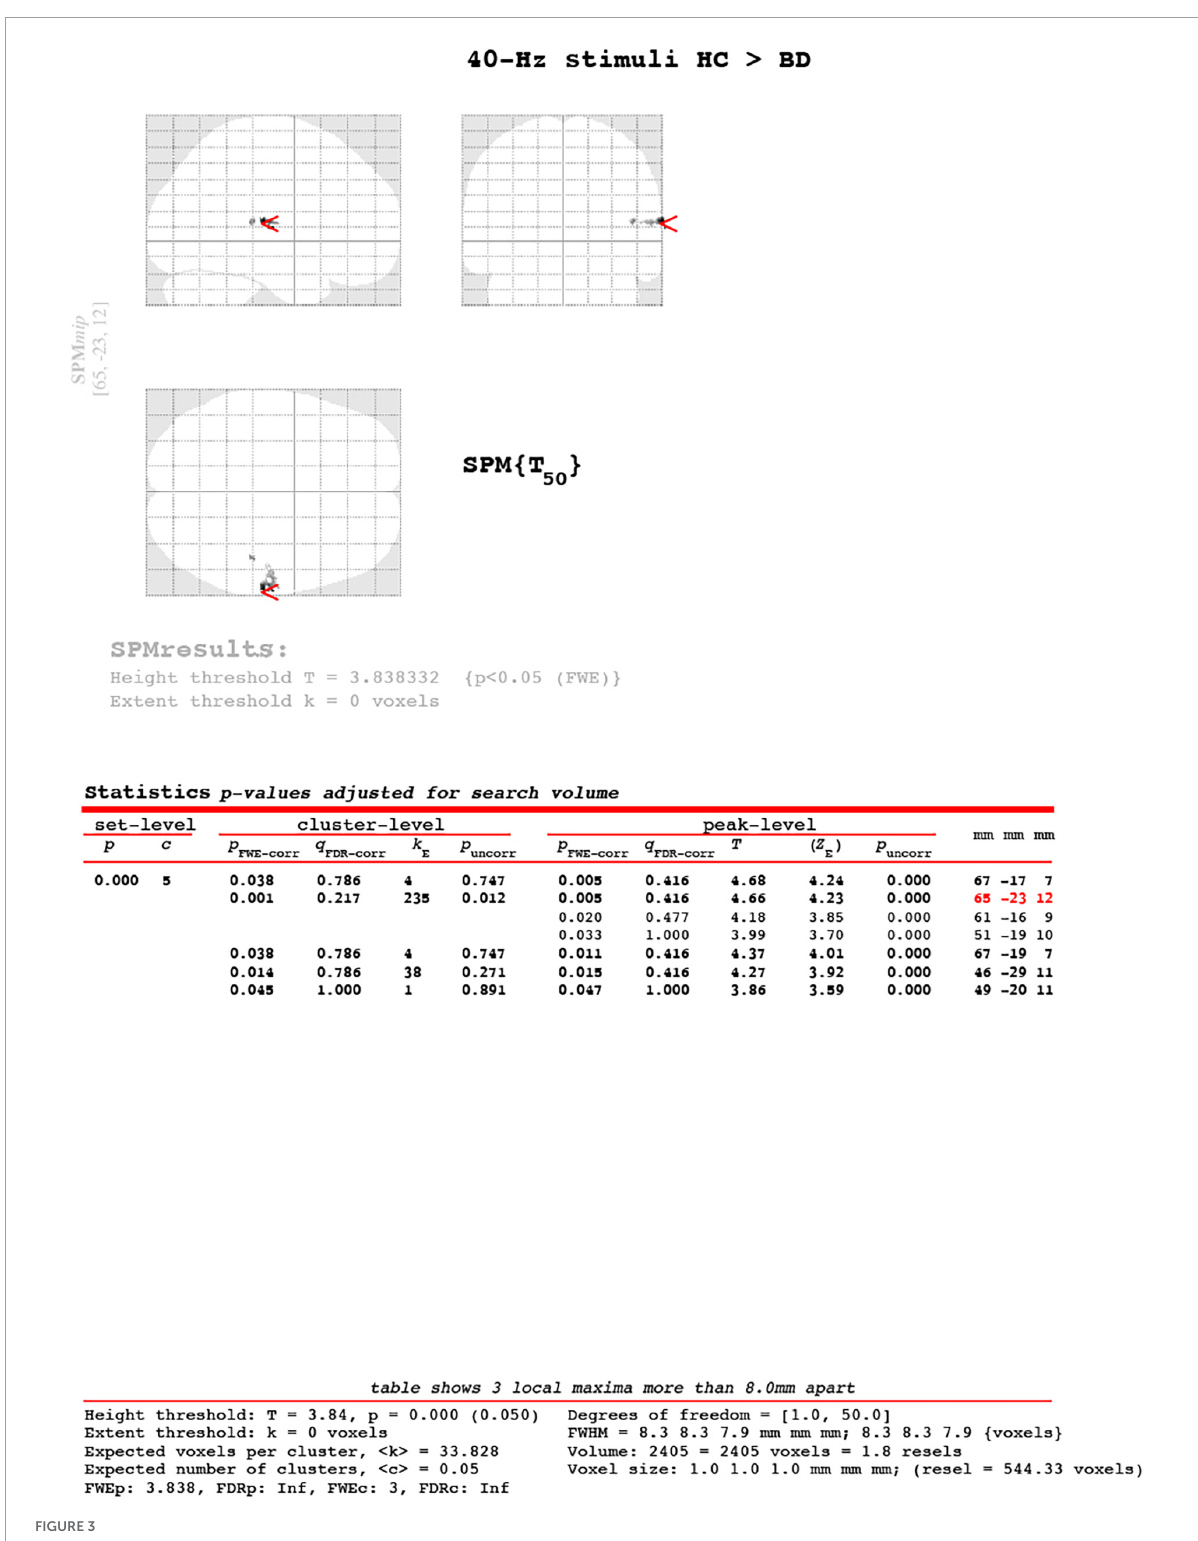
FIGURE3 Cluster-level of ASSR-BOLD contrast HC group > BD group for 40-Hz stimuli using SPM 12 defined regions of interest as the right Brodmann areas 41 and 42. The main cluster located [65, − 23, 12], the cluster-level was kE = 235, pFWE-corrected = 0.001. The Expected voxel per cluster was < k > = 33.828. The [x, y, z] locations are listed in Montreal Neurological Institute